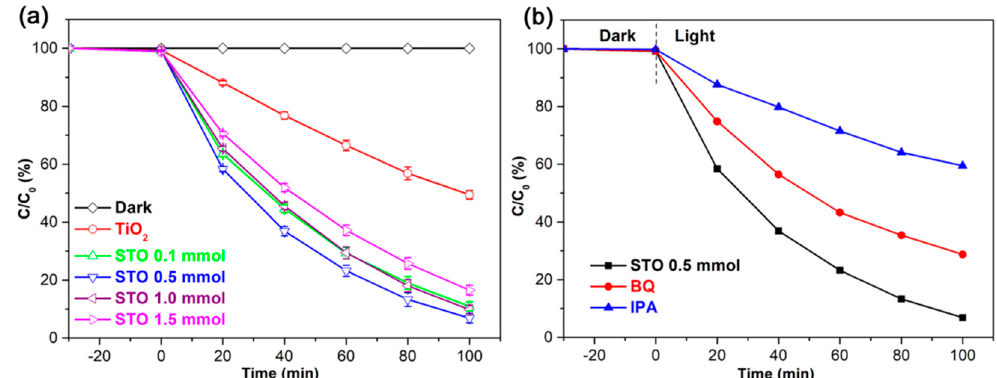
Figure 11. ( a ) Photocatalytic activity of TiO 2 (24 h) and STO hierarchical nanospheres with different molar ratios of n Sn / n Ti : 1%, 5%, 10%, and 15%. ( b ) Photocatalytic degradation of methylene blue (MB) with STO (0.5 mmol) hierarchical nanospheres in the absence and presence of scavengers (BQ and